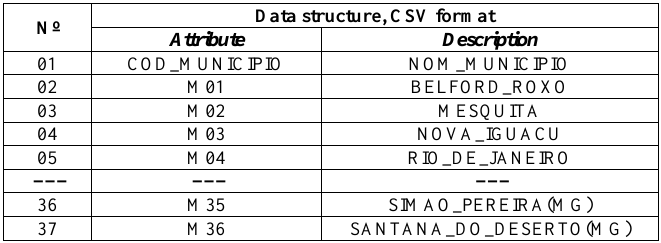
Table 6: COD_ MUNICIPIO.